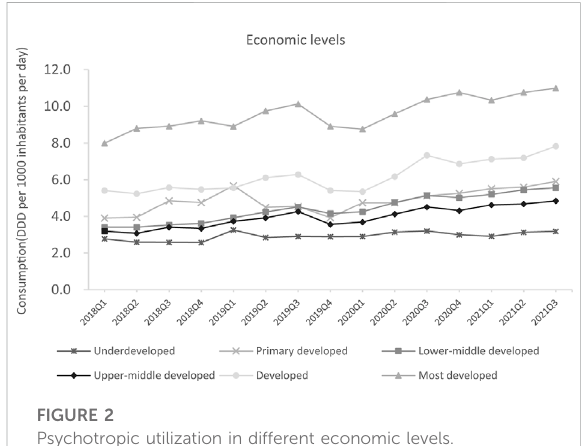
FIGURE 2 Psychotropic utilization in different economic levels.